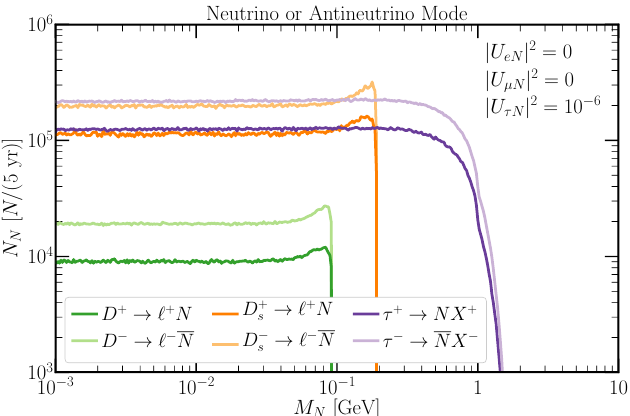
Figure 20 . Number of tau-coupled heavy neutral leptons N traveling toward the DUNE MPD as a function of mass M N , assuming (cid:12)ve years of data collection. We have (cid:12)xed The expected rate is independent of which mode the beam is operating in; all parent particles are una(cid:11)ected by the focusing magnets. The di(cid:11)erent meson-decay contributions are indicated by di(cid:11)erent colors: D mesons (green), D s mesons (orange), and secondary (cid:28) decays (purple). Dark colors indicate positively-charged particle decays, where faint ones indicate negatively-charged particle